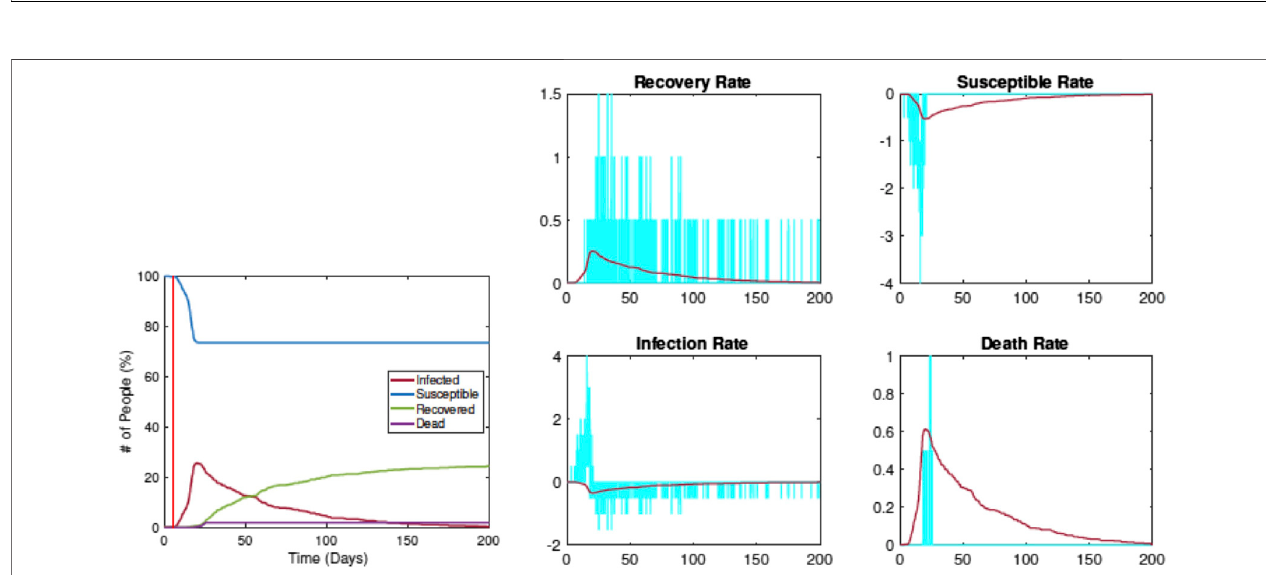
FIGURE6| EstimationofSIRDparametersfromdatasimulatedbyRAW-ALPSforthecasewhentherestrictionsareimposedonDay5.Onceagain,thepandemic curves generated by the SIRD model with estimated parameters match the RAW-ALPS output.